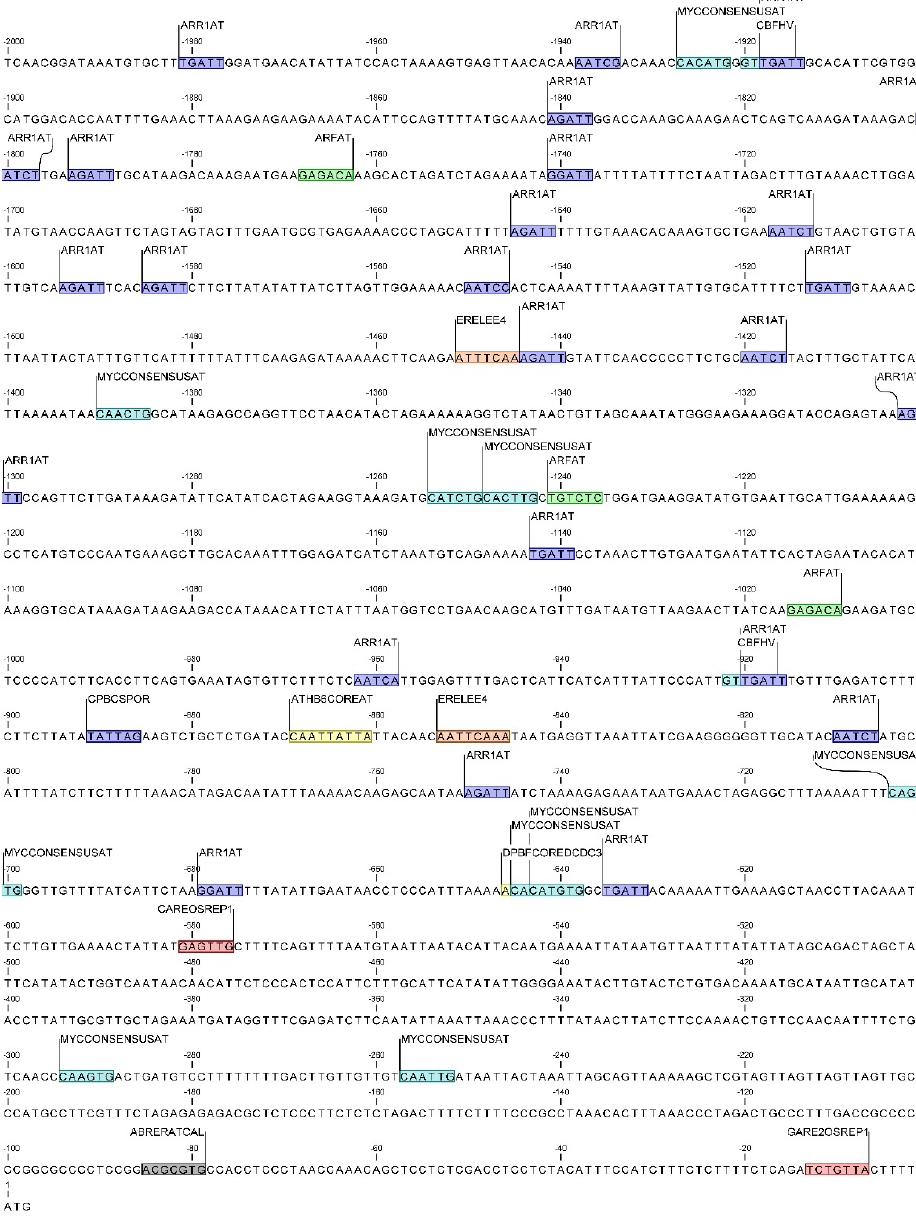
Figure 8. Location of cis -regulatory elements within the DcAOX1 promoter, involved in cold-stress response (in light blue) in response to plant hormones: auxin (green), cytokinin (dark blue), abscisic acid (yellow), gibberellin (red), ethylene (orange), and calcium (grey).